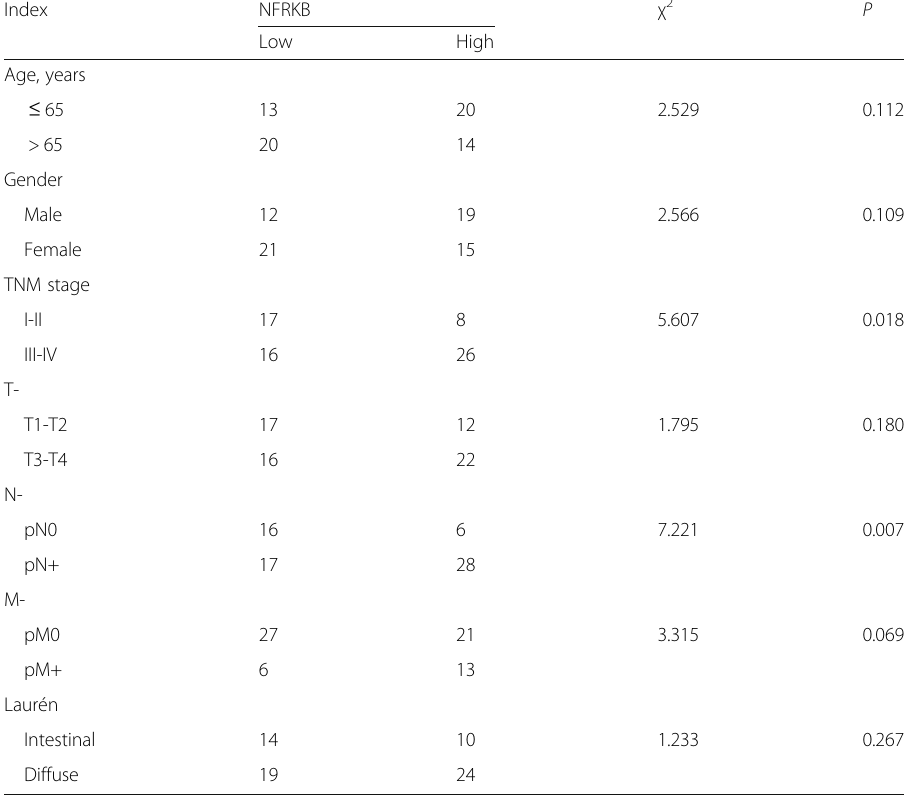
Table 3 Association of NFRKB with clinicopathological variables in GC patients